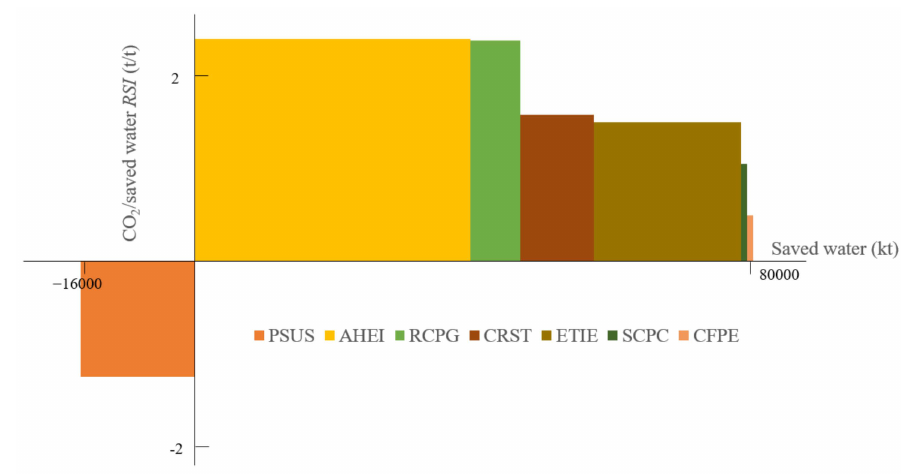
Figure 15. SRC of water saving and CO 2 emissions in 2030.